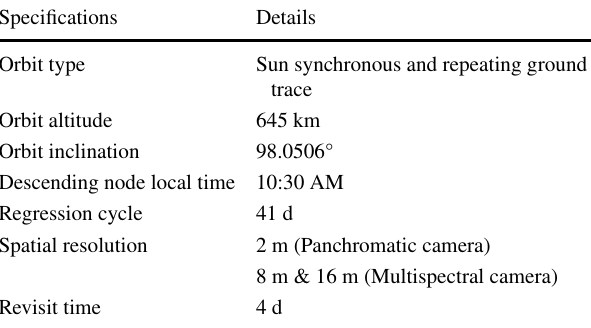
Table 1 Specifications of the GF-1